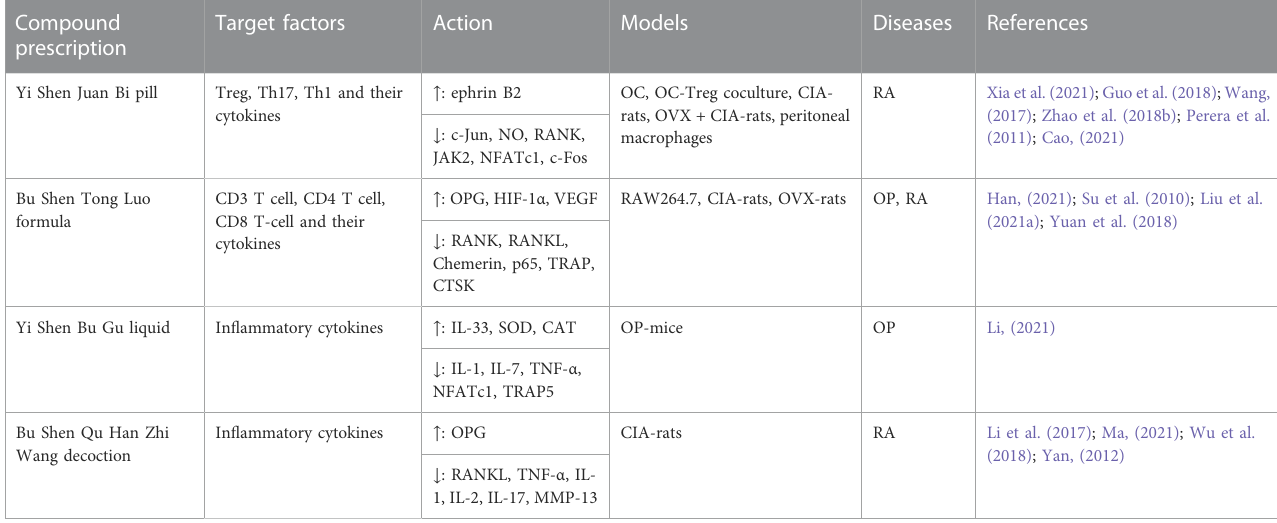
TABLE 1 Immunoregulation mechanisms by which tonifying kidney-yang of TCM compound prescription inhibit osteoclastogenesis. Compound